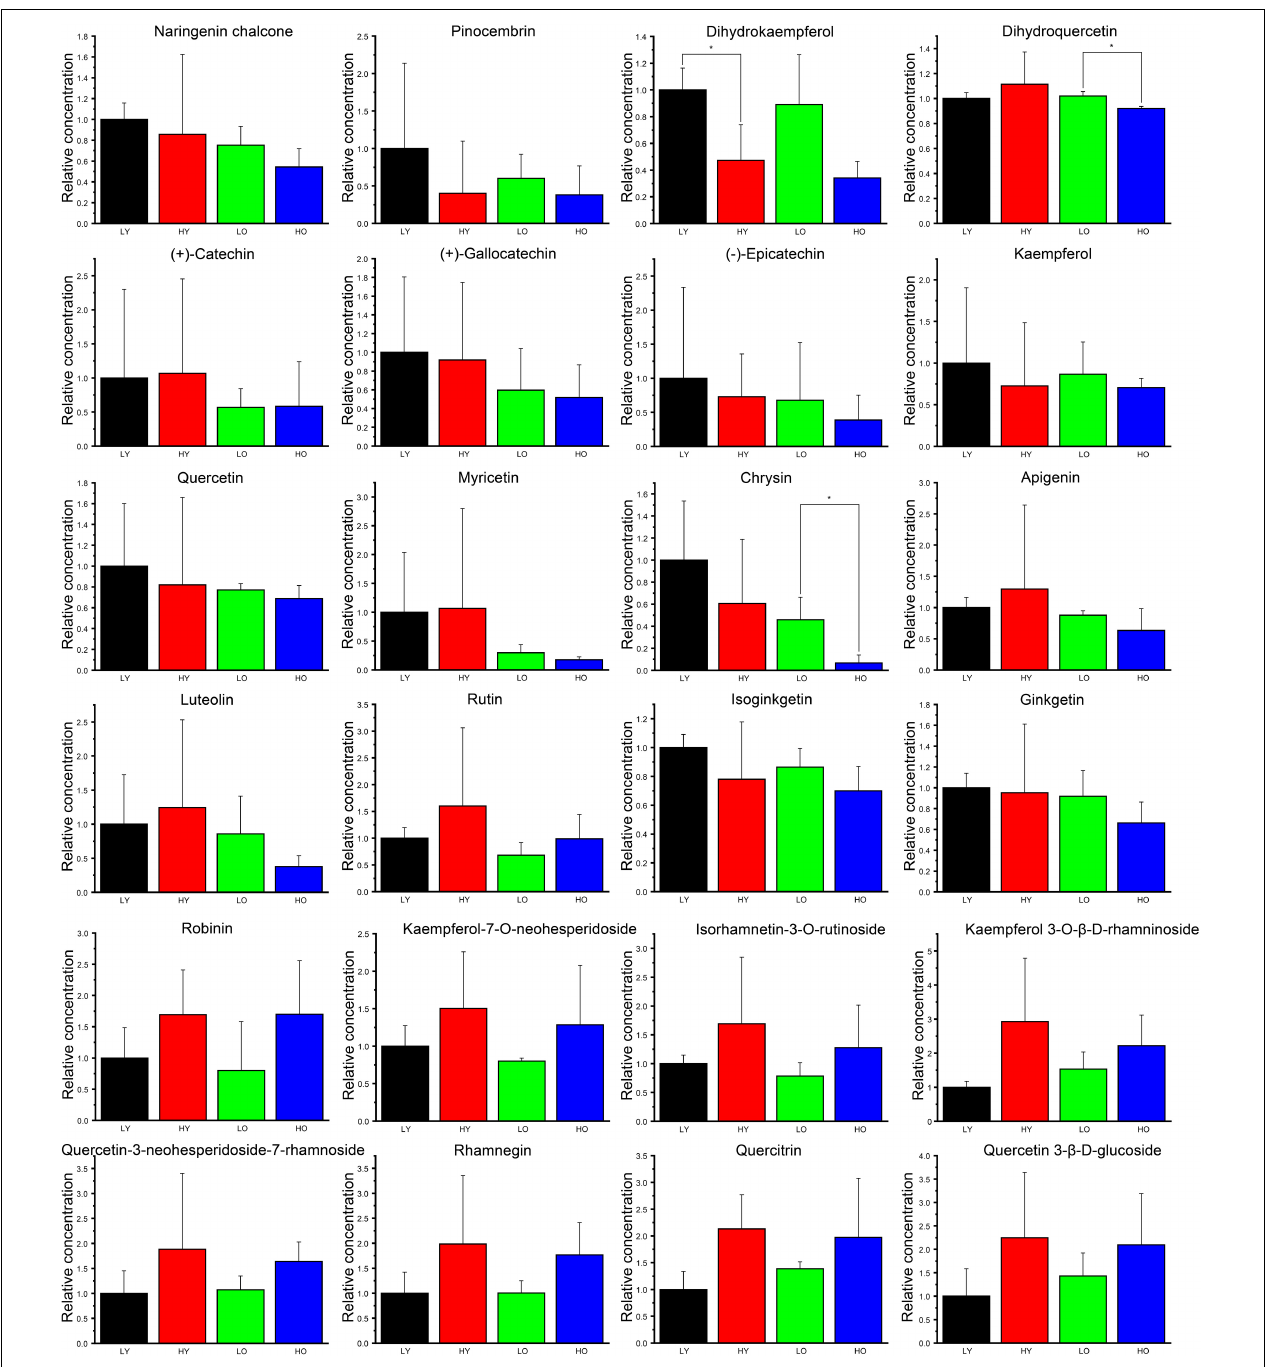
FIGURE 5 | The relative concentration of identified flavonoids and derivatives. The black column indicates group LY. The red column indicates group HY. The green column indicates group LO. The blue column indicates group HO. Data are represented as the means ± SD of three biological replicates. Asterisks indicate significant differences ( p < 0.01, Student’s t